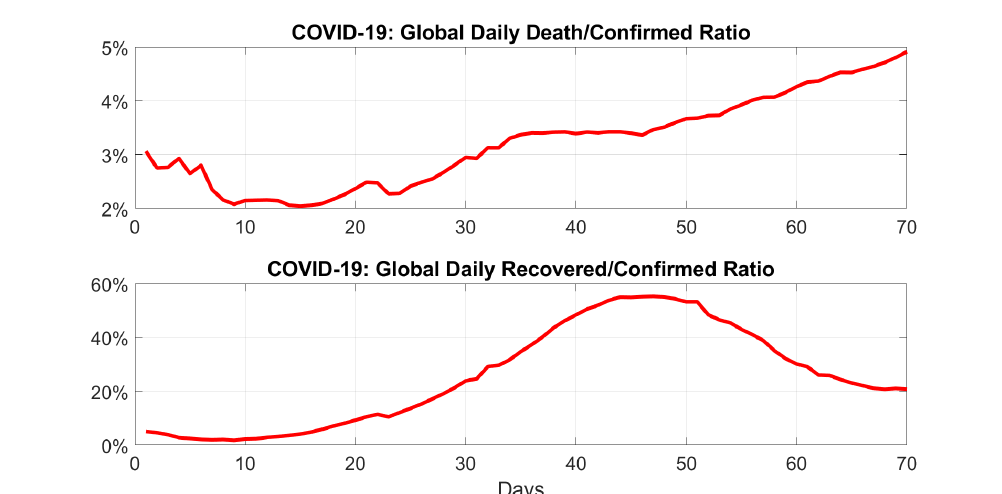
Figure 9. The global death (and recovered) to confirmed ratio of COVID-19 from 22 January to 31 March.